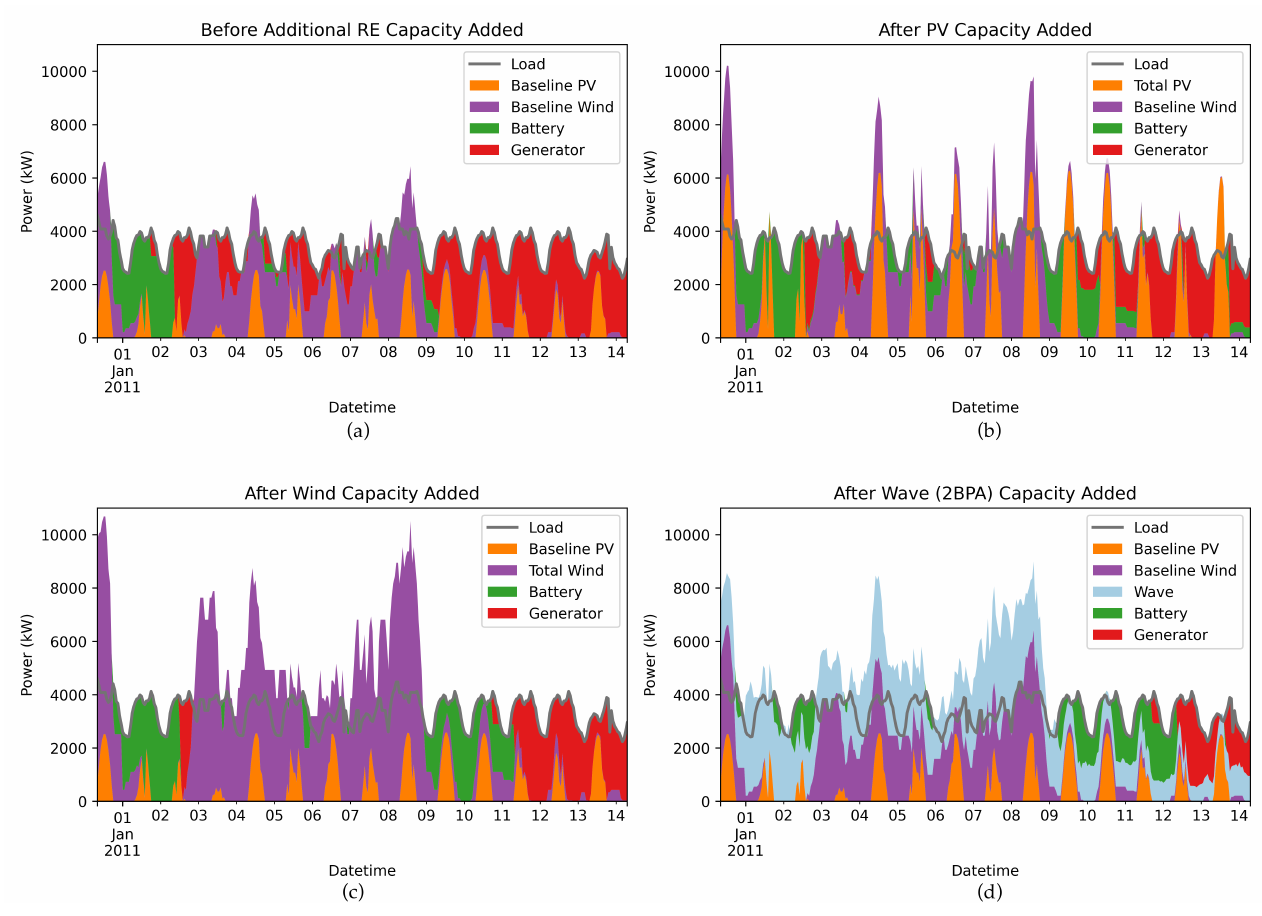
Fig. 4. Microgrid dispatch operation for (a) the baseline system, (b) the baseline system with 5 MW of PV capacity added, (c) the baseline system with 5 MW of wind capacity added, and (d) the baseline system with 5 MW of wave capacity added (2BPA). In all four plots, the load is shown by the gray line, PV generation in orange, wind production in purple, battery discharge energy in green, biofuel generator production in red, and wave generation in blue.